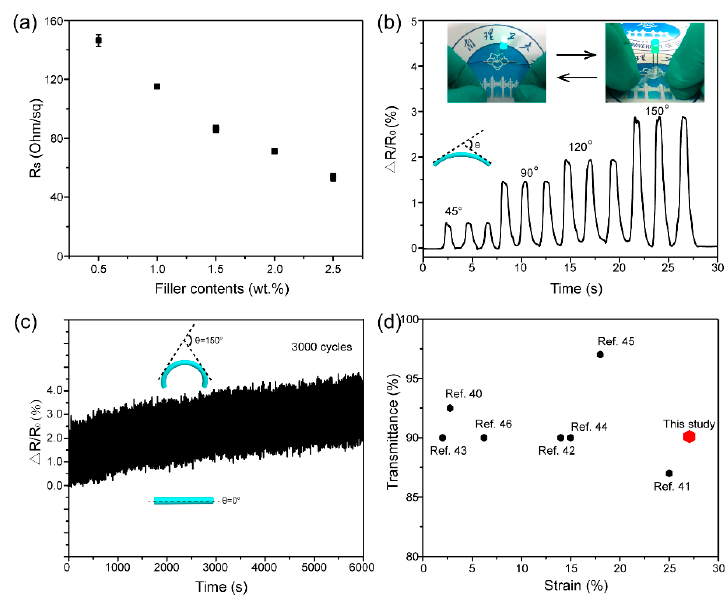
Figure 4. Electrical properties of CNF/AgNW conductive paper: ( a ) Sheet resistances of conductive paper; ( b ) plots of resistance change of conductive paper as a function of time for the bending angle in the range of 45 − 150 ◦ ; ( c ) lifetime test at a bending angle of 150 ◦ (frequency: 0.5 Hz)—the resistance change curves were recorded for 3000 cycles; ( d ) comparison of strain and transmittance of this study with other transparent, flexible, and conductive paper.